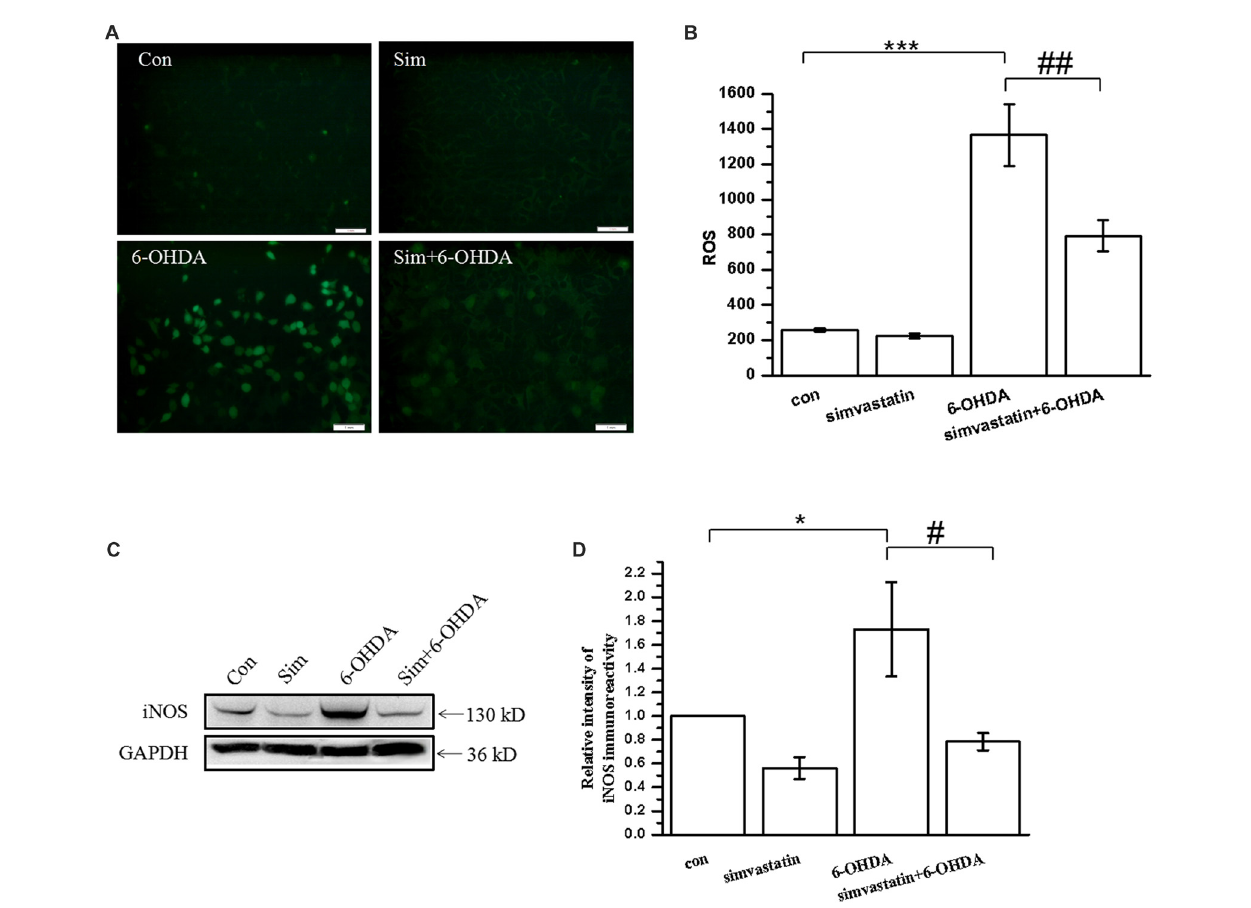
FIGURE 2 | Simvastatin reduced 6-OHDA-induced reactive oxygen species (ROS) and inducible nitric oxide synthase (iNOS) production in SH-SY5Y cells. (A) SH-SY5Y cells treated with 1 µ mol/L simvastatin and 100 µ mol/L 6-OHDA for 6 h, and intracellular ROS was measured using the carboxy-H2DCFDA method. (B) Relative quantitative analysis of intracellular ROS. (C) SH-SY5Y cells treated with simvastatin and 6-OHDA for 24 h, and iNOS expression detected by western blot. (D) Relative quantitative analysis of iNOS expression. Scale bar, 50 µ m. Data were obtained from three independent experiments. Statistical analysis was by Dunnett’s T3 or LSD post hoc test based on ANOVA; data are expressed as mean ± SEM. ∗ P < 0.05, ∗∗∗ P < 0.001, # P < 0.05, ## P < 0.01.